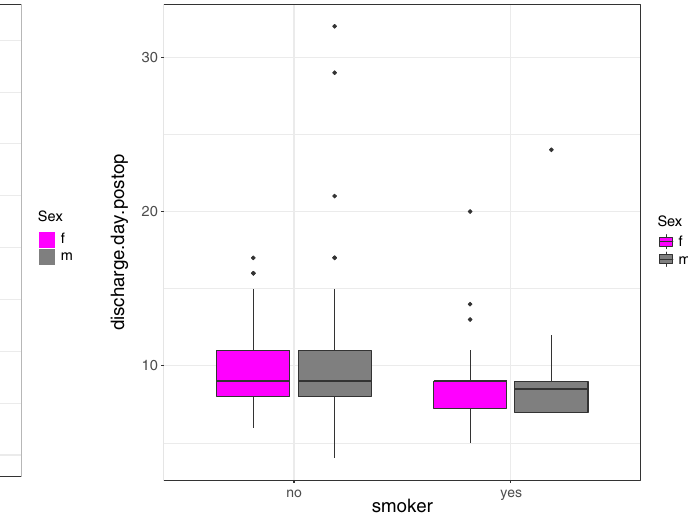
Figure 4: Comparison of the discharge day in female and male smokers as well as non -